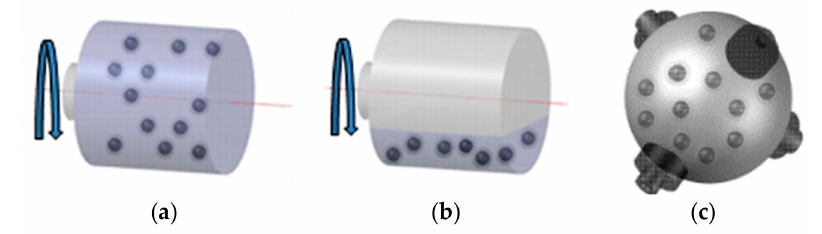
Figure 7. Schematic diagram of the three curing modes. ( a ) Mode 1; ( b ) Mode 2; ( c ) Mode 3.